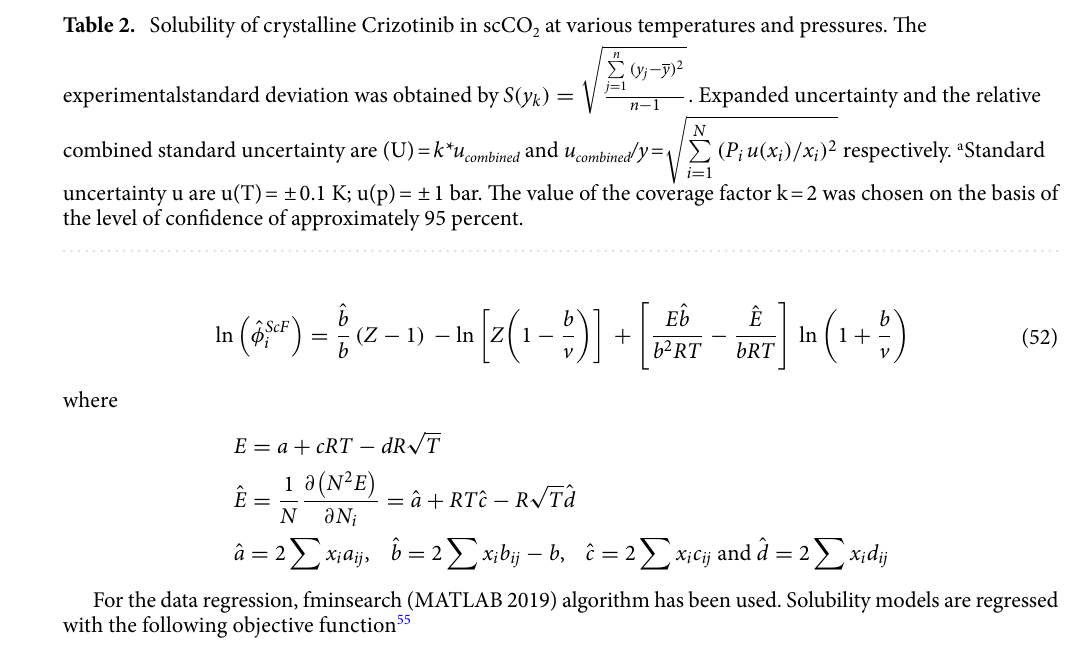
n ( y j y ) 2 − j = 1 (cid:31) 1 . Expanded uncertainty and the (cid:30) n = −